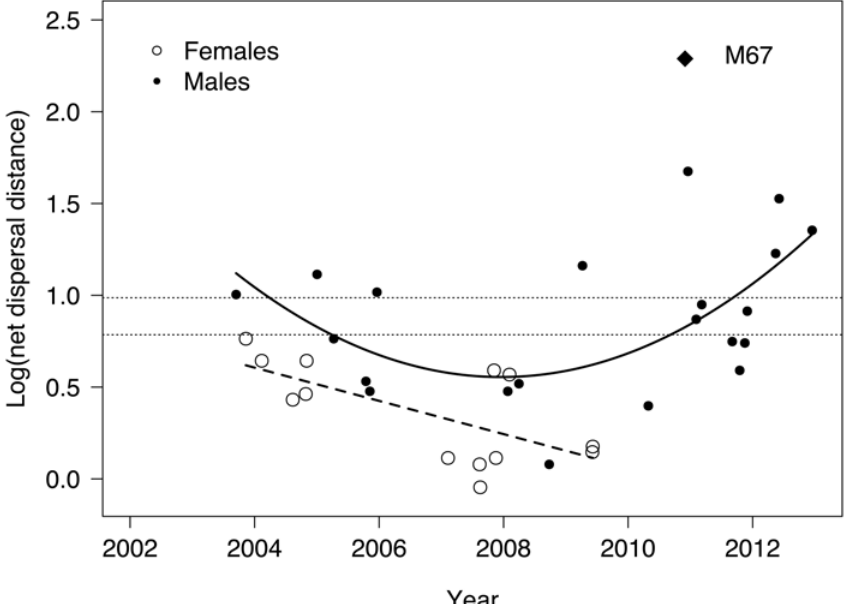
Fig 4. Log-transformed net dispersal distance in subadult female and male leopards in Phinda Private Game Reserve, South Africa, 2002 – 2012. Dashed line shows a significant linear regression fitting the female data (R 2 = 0.392, F 1,11 = 8.728, p = 0.013), solid black curve shows a significant quadratic relationship in the male data (R 2 = 0.250, F 1,18 = 3.247, p = 0.029) after removal of one extreme outlier (M67, diamond). Horizontal fine-dotted lines demark the diameter of one average adult female (6.1 km) and male (9.7 km) home-range. Dispersal beyond one adult female home-range diameter defines emigration. Subadult males dispersing further than one adult male home-range diameter escaped mate competition with their putative father.